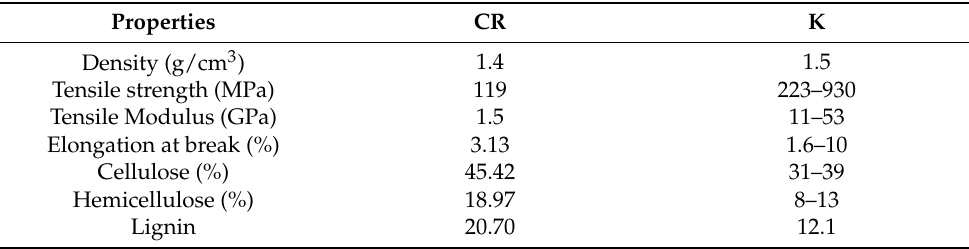
Table 1. Physical and mechanical properties of CR and kenaf